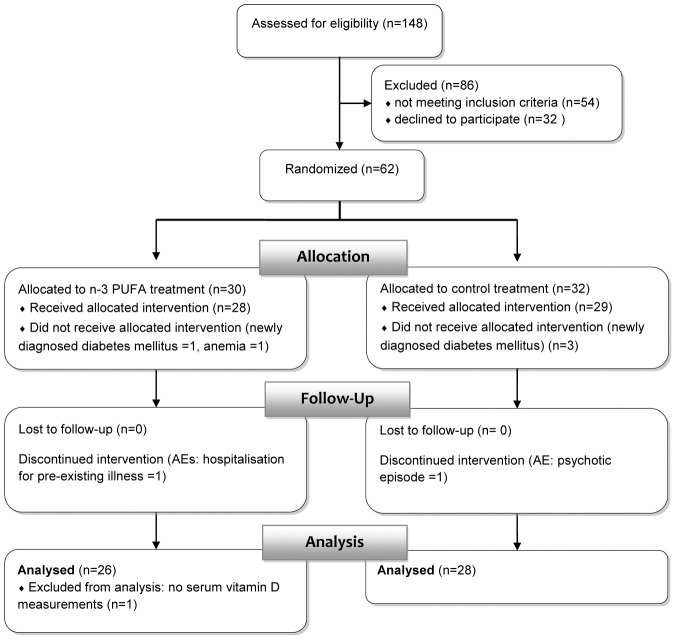
CONSORT flowchart, adapted from [21].